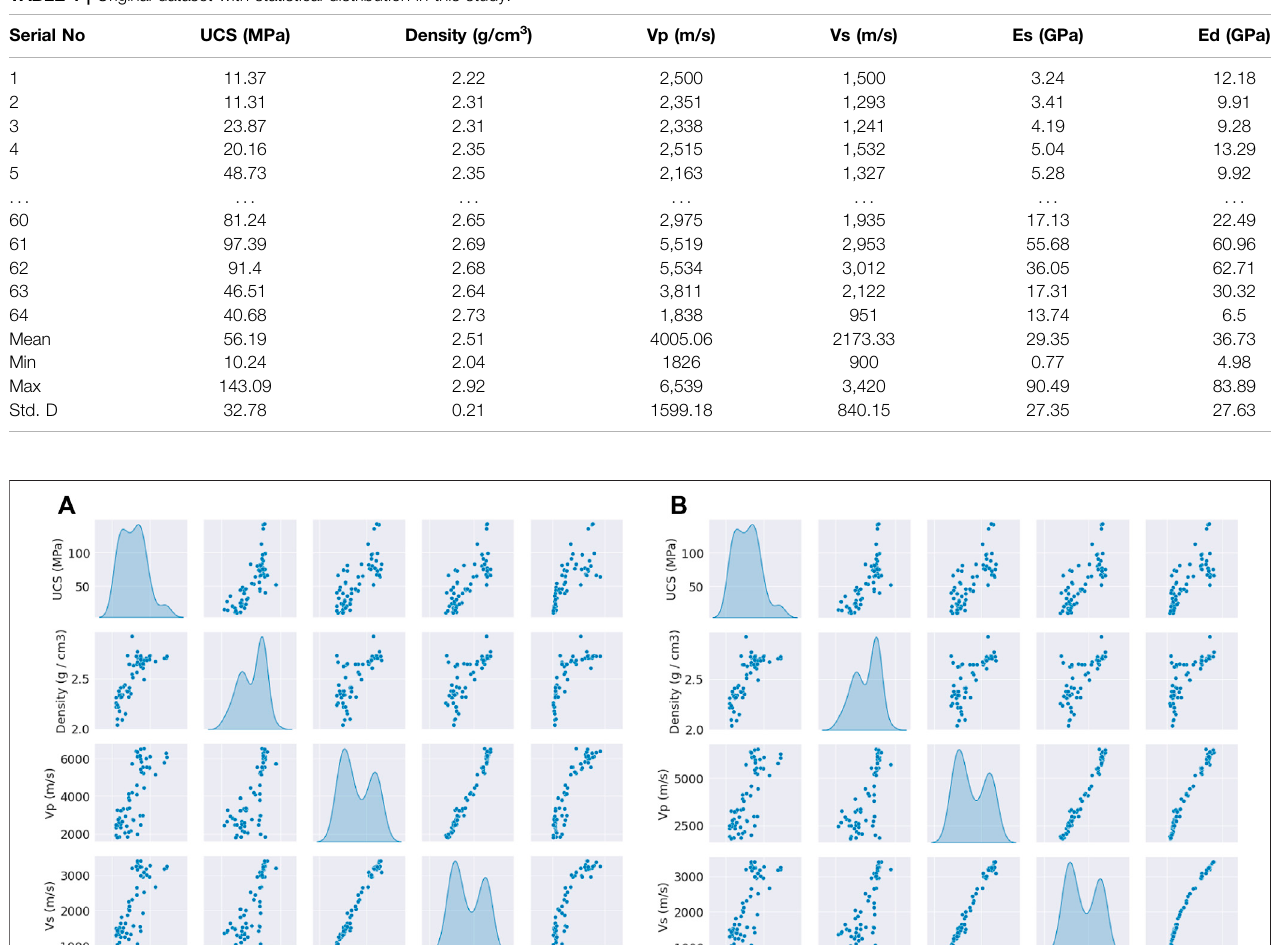
TABLE 1 | Original dataset with statistical distribution in this study.